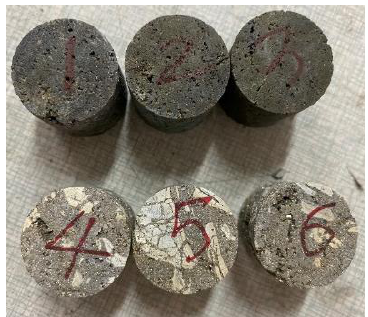
Figure 4. Specimens of Brazilian splitting test.